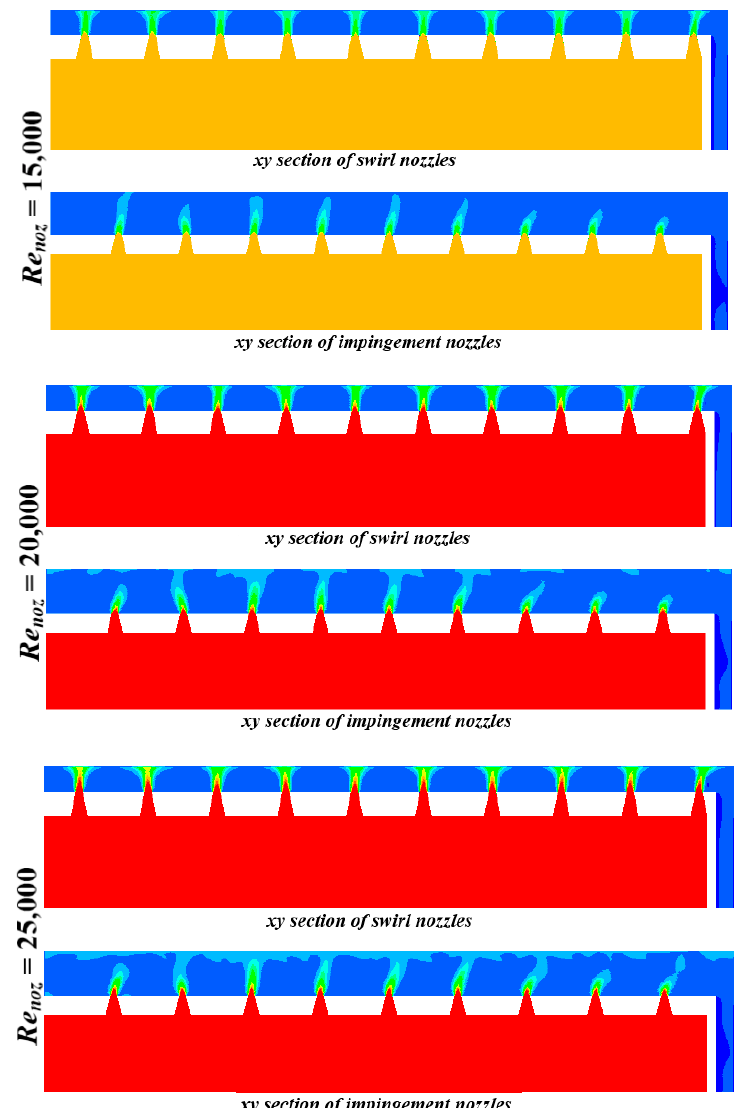
Figure 12. Coefficient of local pressure contours of the compound cooling unit at different xy sections.